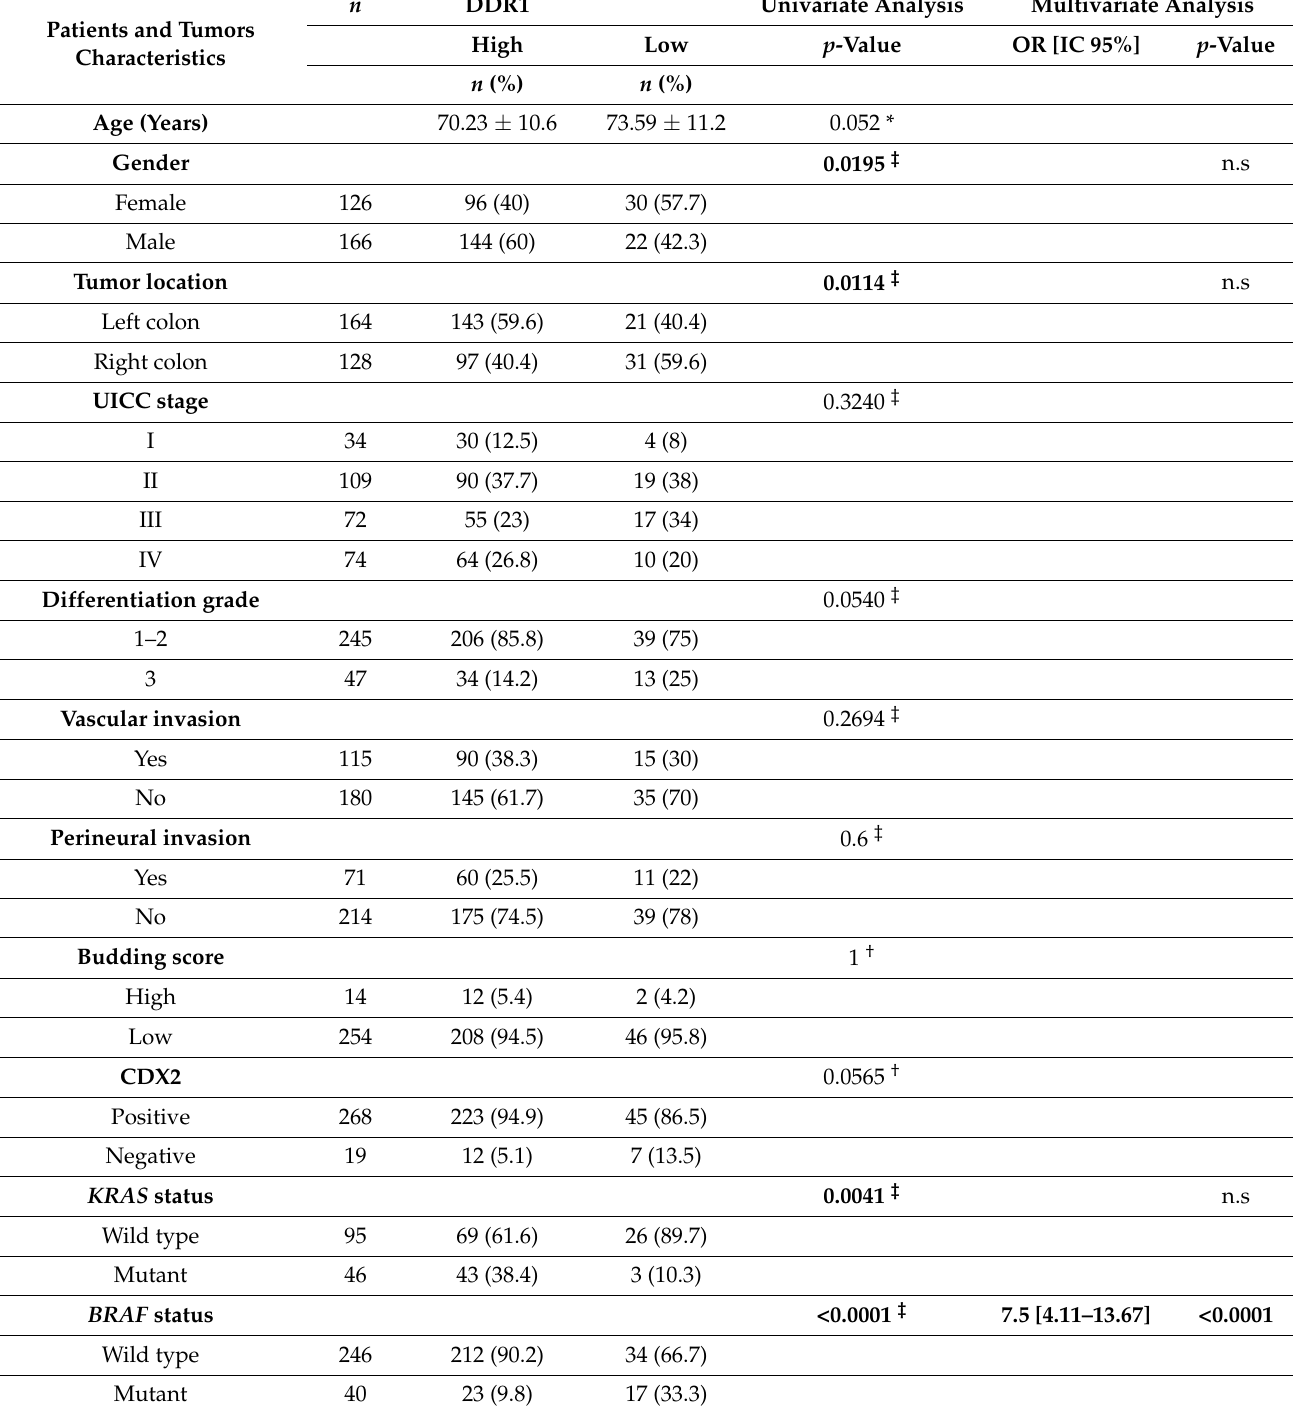
Table 2. Relationship between DDR1 expression and clinical and molecular